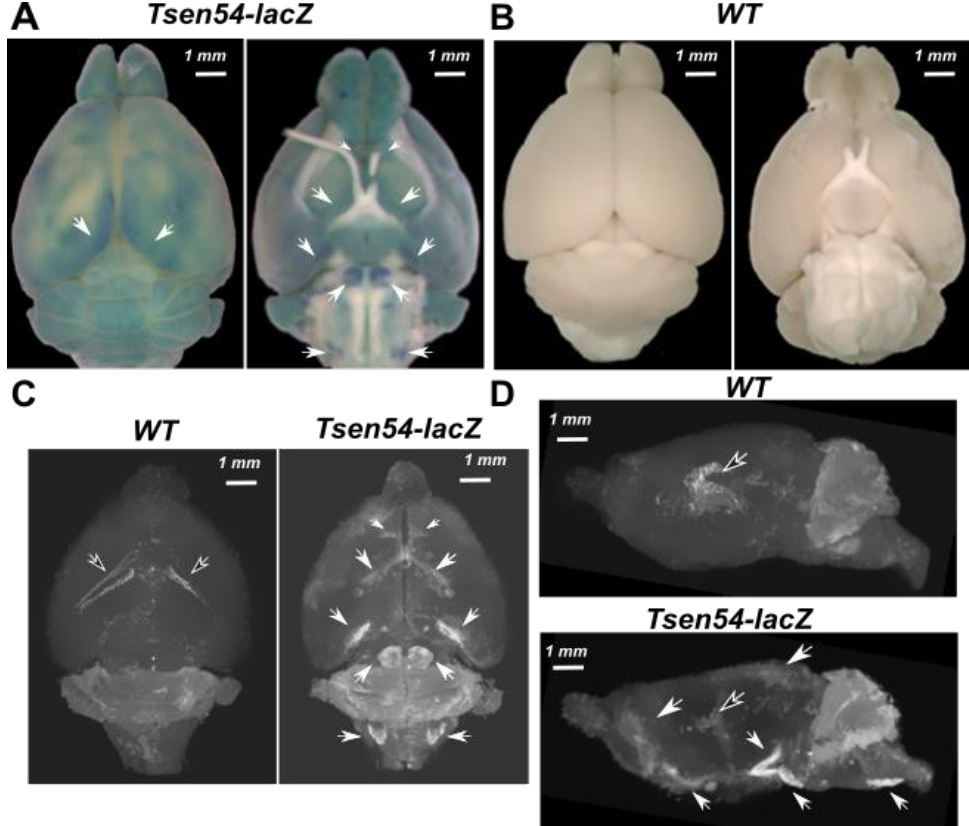
Figure 1. Three-dimensional imaging of Tsen54-lacZ expression in intact adult mouse brain by micro-CT . ( A ) Dorsal and ventral views of Tsen54-lacZ mouse brain stained with X-gal/FeCN and visualized by stereomicroscope; ( B ) dorsal and ventral views of littermate control whole mouse brain stained with X-gal/FeCN and visualized by stereomicroscope. ( C ) Representative maximum intensity projection (MIP) micro-CT images scanned with the resolution 5 µ m/voxel of whole brain from Tsen54-lacZ (N = 3) and wild type (WT) (N = 3) animals. ( D ) Sagittal view of MIP images of the brains represented in panel ( C ). Additional regions of increased density (indicated by white arrows) in Tsen54-LacZ brains correspond to precipitated product of X-gal substrate converted by β -gal. White arrows indicate the regions of the elevated density in Tsen54-lacZ brains imaged by micro-CT and corresponding regions in the brains imaged by microscopy. The arrows filled with black indicate the endogenous densities detected both in the wild type and experimental